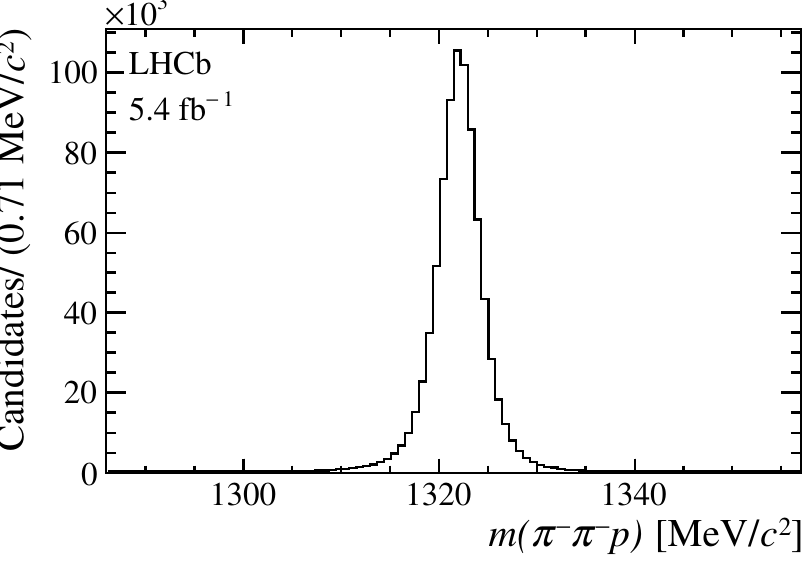
Figure 3 . Mass distribution m ( π − π − p ) showing the Ξ − → Λπ − signal for events satisfying the trigger and the offline requirements described in the text for Ξ −